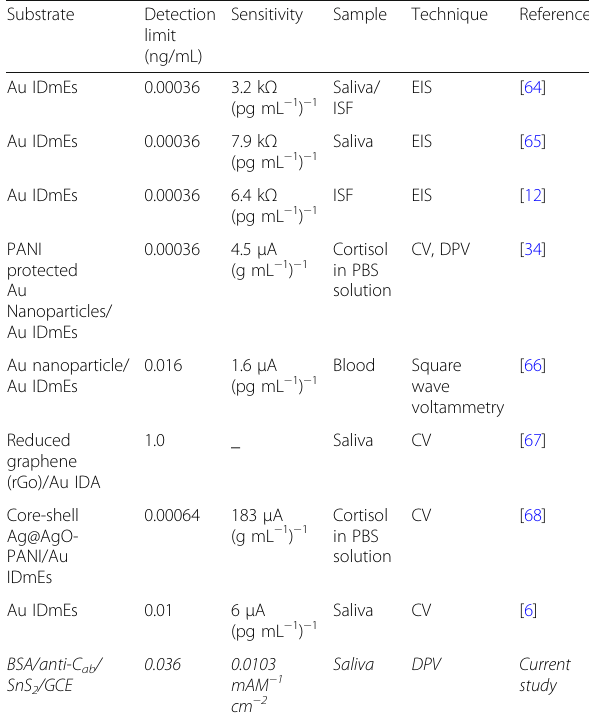
Table 3 Comparisons of modified gold electrode and the cortisol detection results reported in the literature and in the present